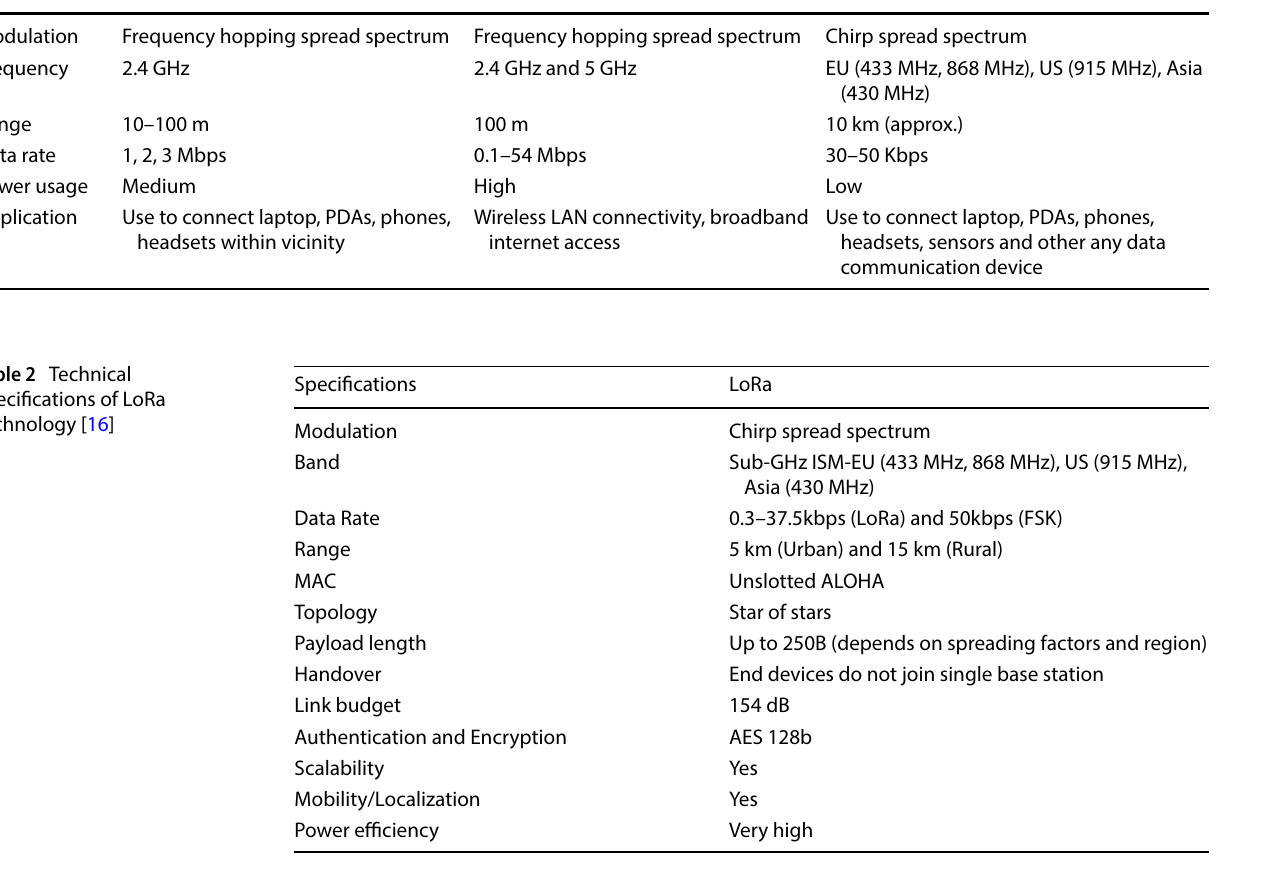
Table 1 Comparison between Wi-Fi, Bluetooth and LoRa Technology for IoT Specifications Bluetooth 5.0